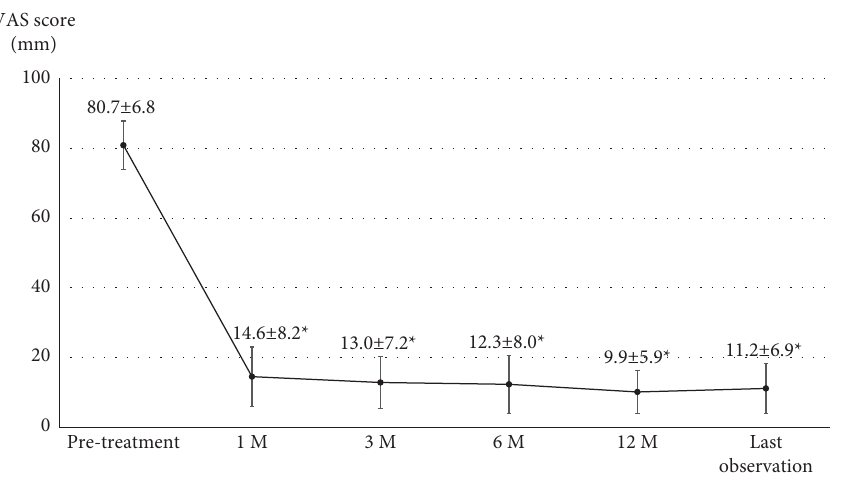
Figure 3: VAS scores from pretreatment to last observation. M, months after treatments; VAS, visual analogue scale. ∗ Signifcant diference compared with pretreatment ( P < 0 .